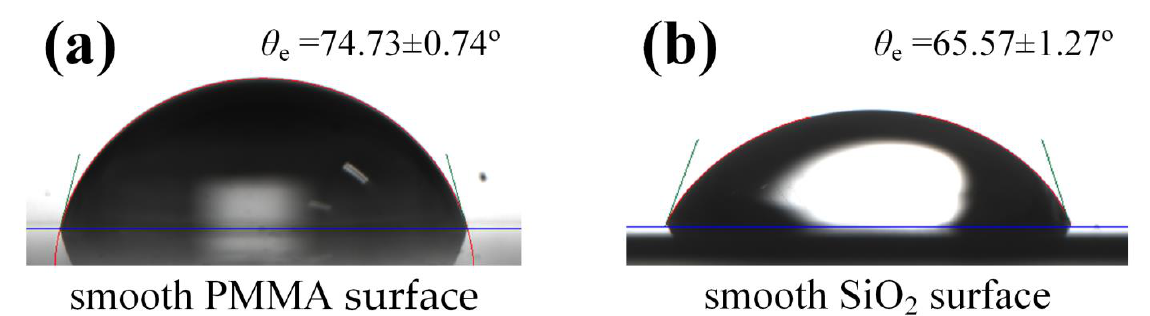
Figure 7. Equilibrium contact angles of water droplets ( a ) on the smooth PMMA surface and ( b ) on the smooth SiO 2 surface.